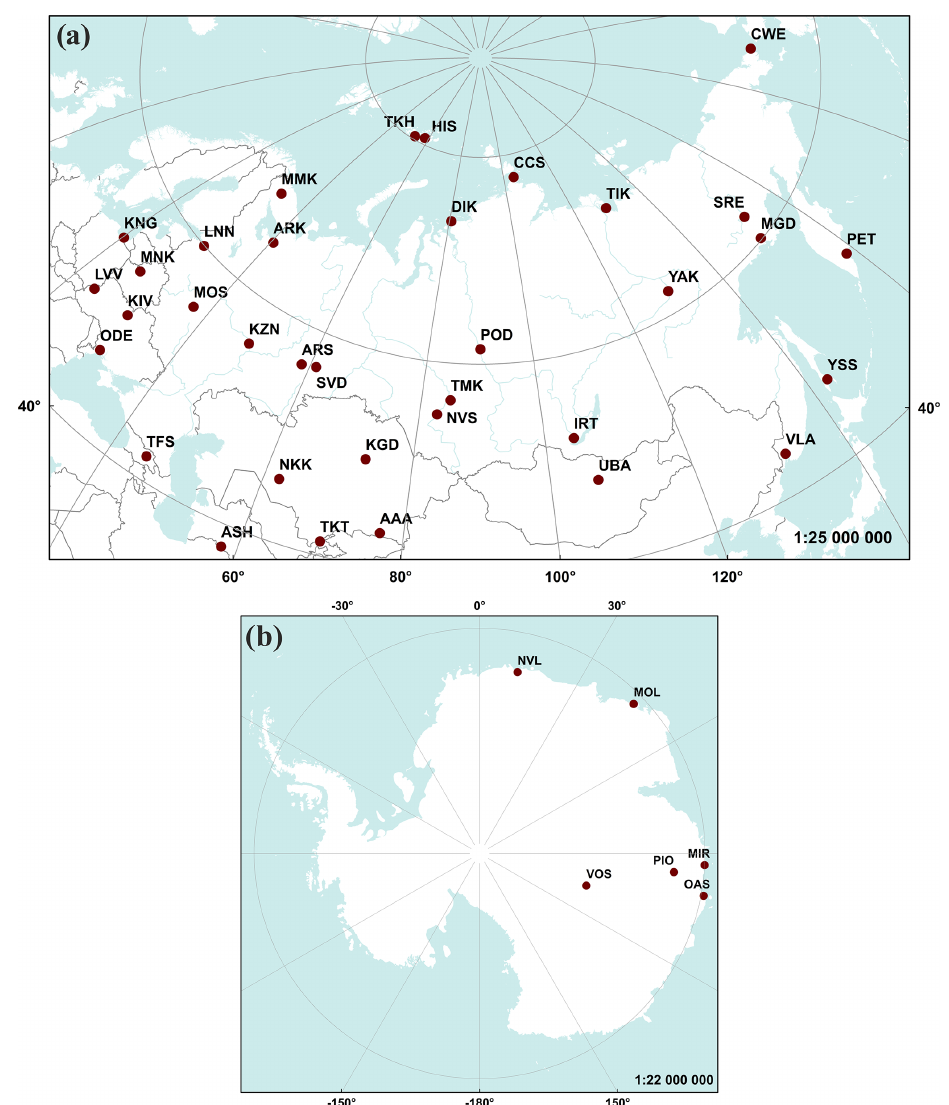
Figure 2. Location of Soviet geomagnetic observatories that provided data for the presented collection: (a) continental territory of the USSR; (b) the